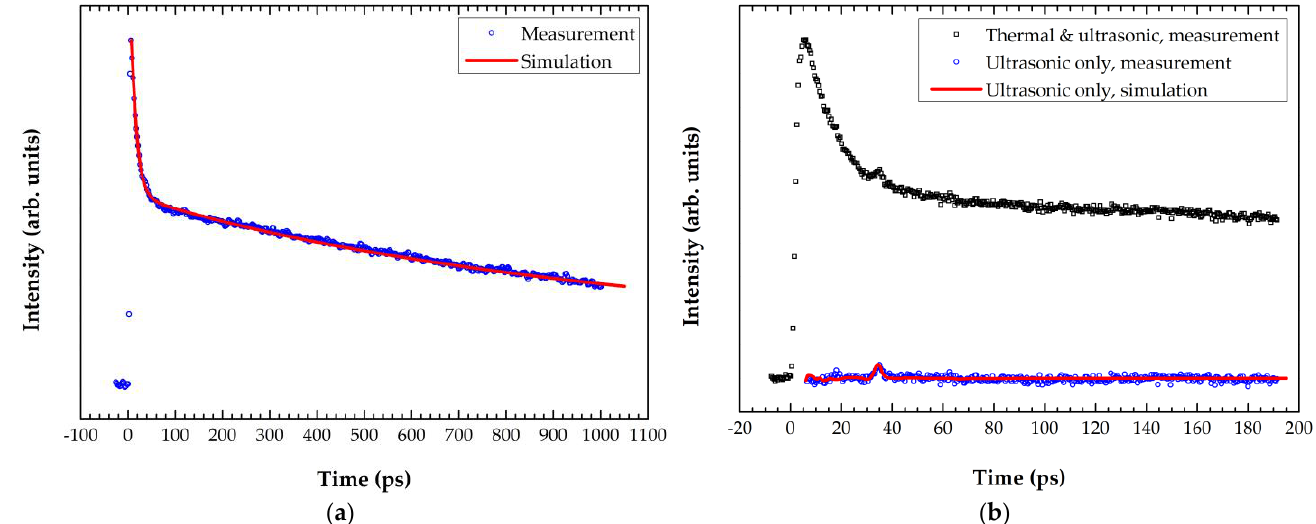
Figure 5. Laser-ultrasonic measurement and curve-fitting results for the 100 nm Al film: ( a ) κ Al = 210 ± 10 W/(m·K) and G Al/Si = 4.5 ± 0.5 m 2 · K/GW were obtained from the thermal response; ( b ) E Al = 56 ± 2 GPa was obtained from the ultrasonic response.